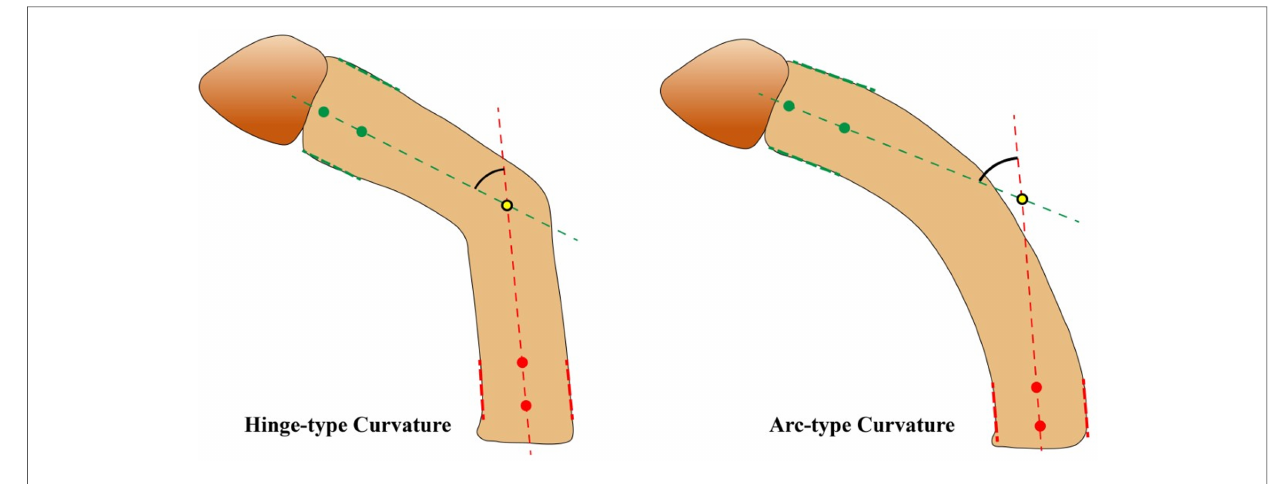
FIGURE 5 Advantage of the 4 key-points approach for hinge-type and arc-type penile